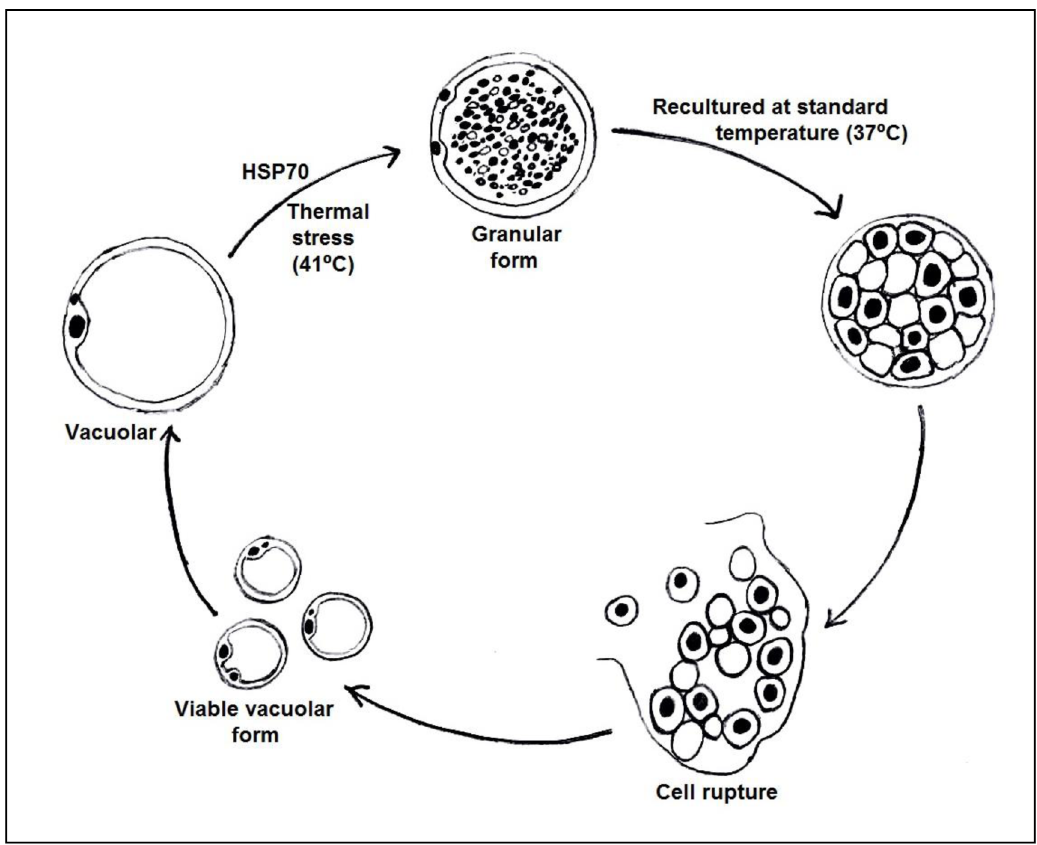
Figure 8. Biological illustration of thermal stressed Blastocystissp .